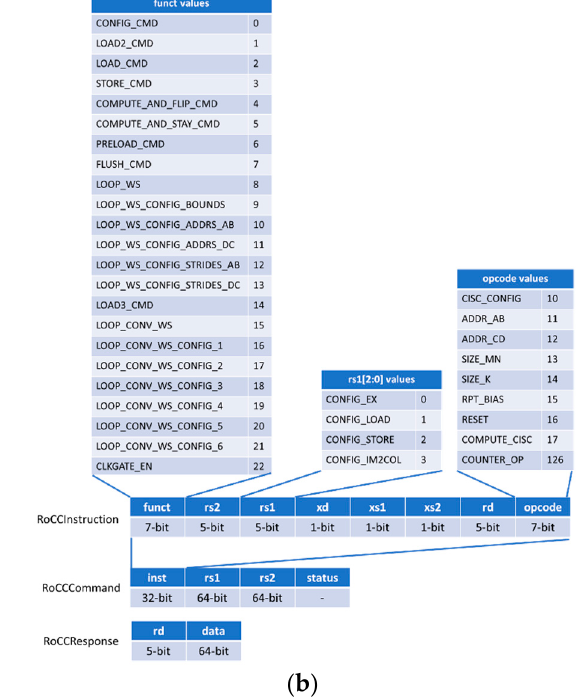
Figure 3. The RoCC interface: ( a ) the RoCC interface signals; ( b ) the RoCC command and response formats.